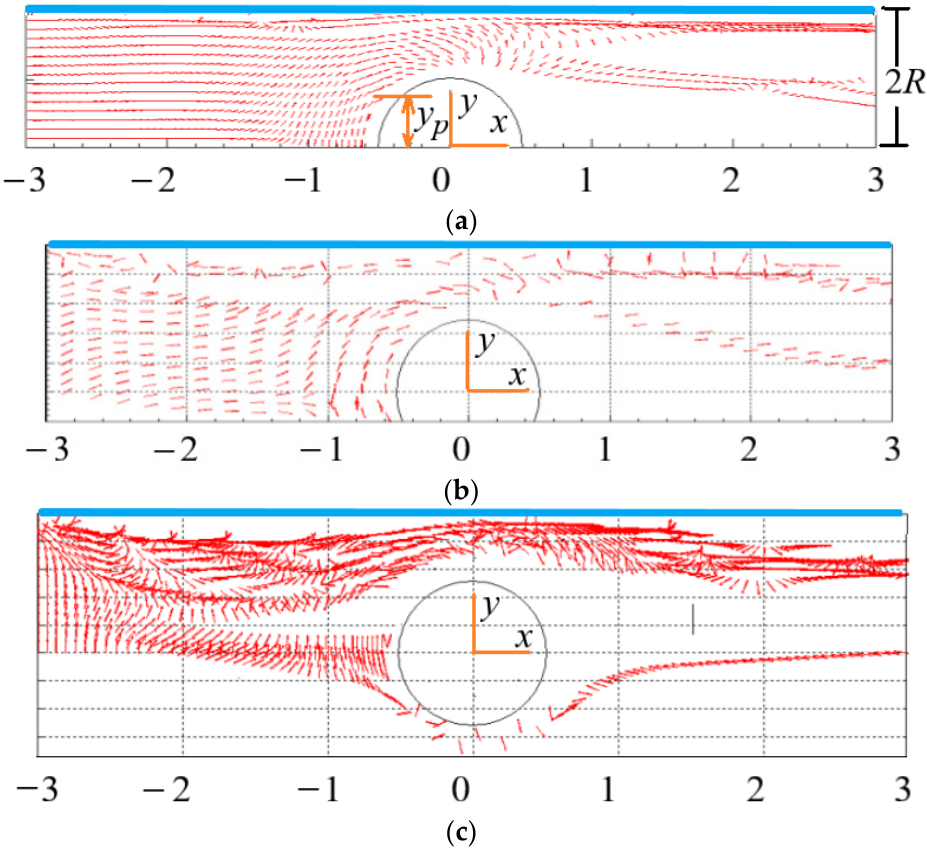
Figure 6. Spatial and orientation distributions of particles with different initial orientation (Re = 2, n = 1.3, β = 8). ( a ) initial orientation θ 0 = 0°. ( b ) initial orientation θ 0 = 45°. ( c ) initial orientation θ 0 = 90°.